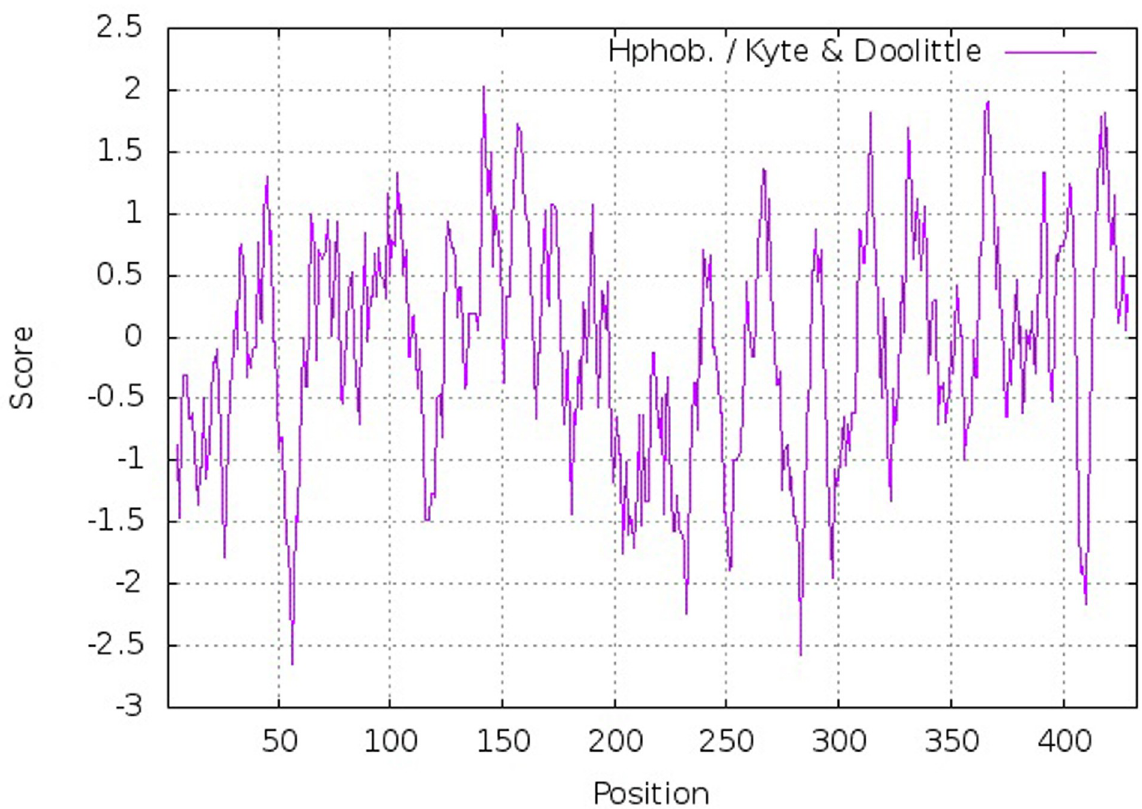
Fig 4. The results of Kyte and Doolittle diagram about the T5AT protein containing 24 hydrophobic regions.